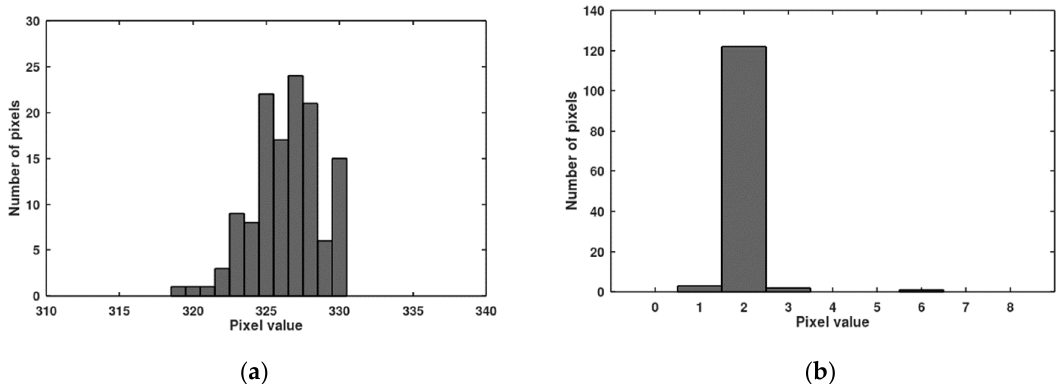
Figure 9. Distribution of photo signal responses ( a ) and dark signal responses ( b ) when the gain correction takes precedence over the offset correction.